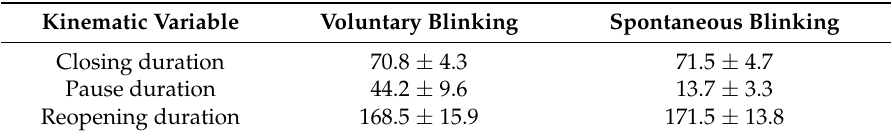
Table 1. Durations of three kinematic variables for two types of blinking (voluntary and spontaneous) for healthy subjects in milliseconds